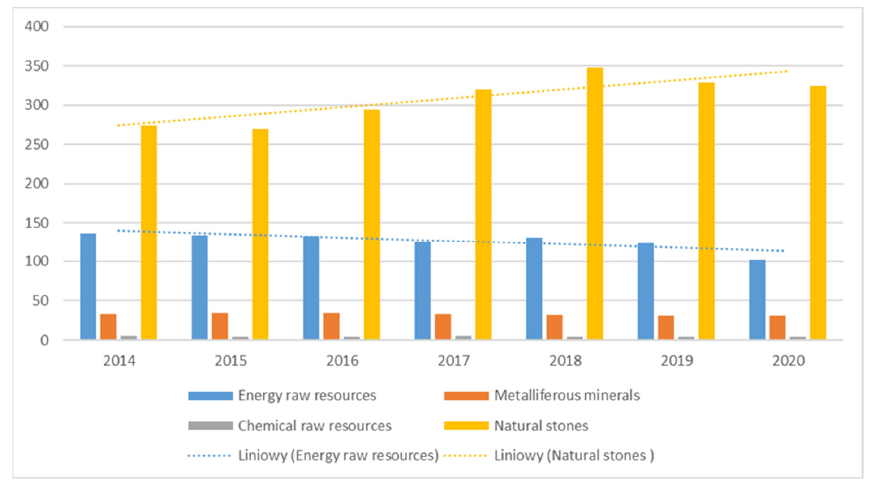
Figure 3. Formation of extraction of individual groups of minerals in Poland for the period of 2014–2020. Authors’ own study based on [21–27].